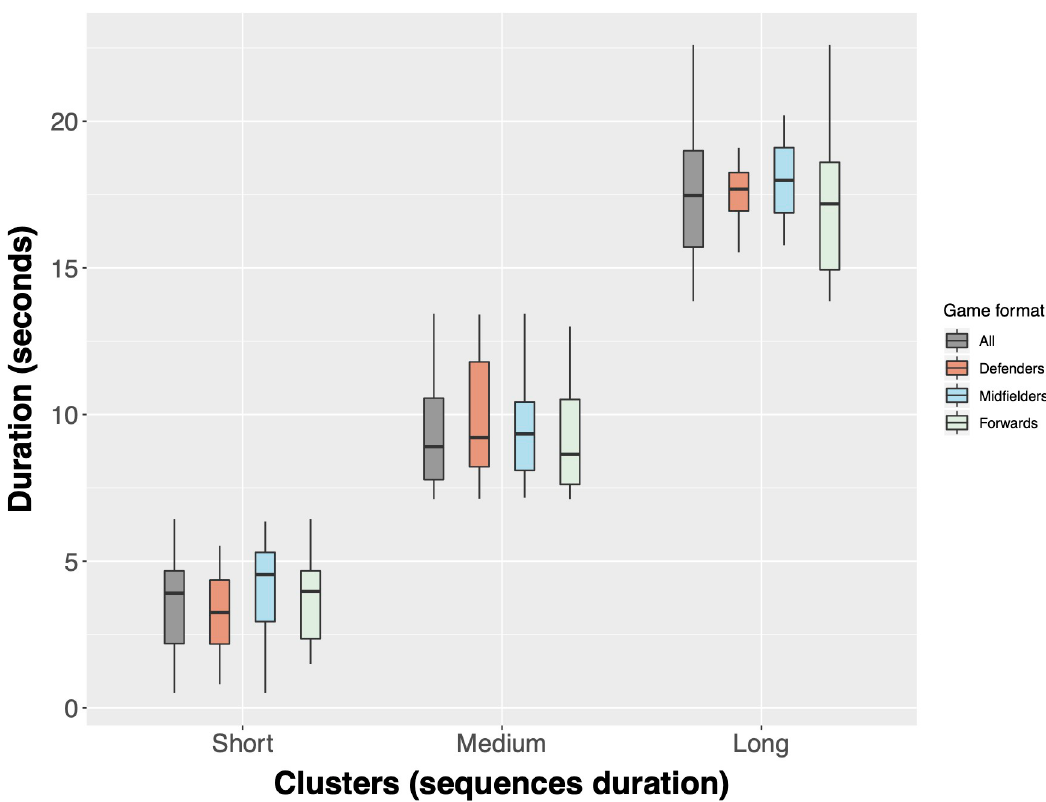
Fig 1. Box plot of the cluster analysis’ results according to the duration of the ball possessions sequences for each analysed game context. The lower and upper hinges correspond to the first and third quartiles (the 25th and 75th percentiles). The upper whisker extends from the hinge to the largest value no further than 1.5 � IQR from the hinge (where IQR is the inter-quartile range, or distance between the first and third quartiles). The lower whisker extends from the hinge to the smallest value at most 1.5 � IQR of the